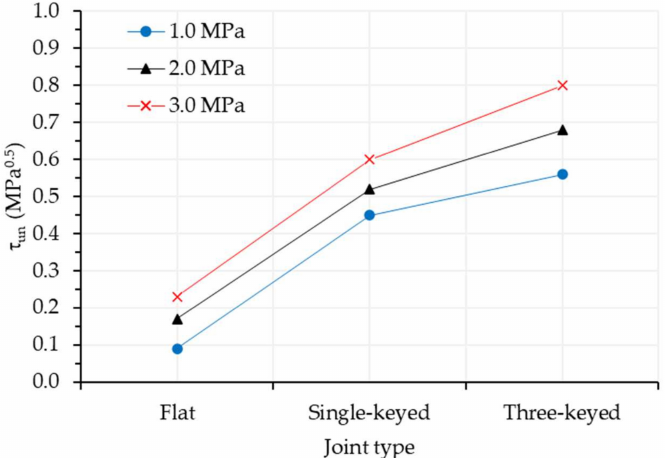
Figure 17. Influence of the number of keys on the maximum normalized shear stress of the RAC dry